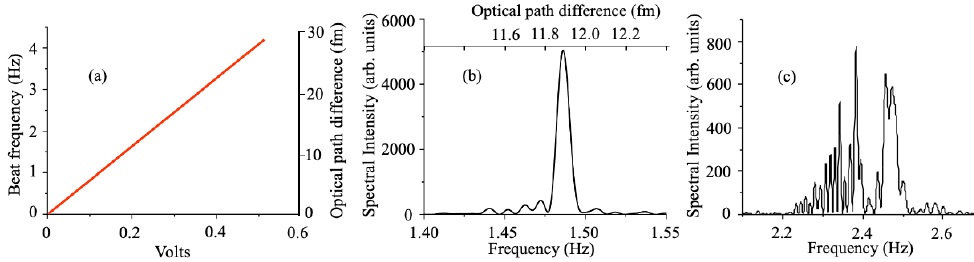
Figure 6. ( a ) Beat frequency versus voltage applied to the LiNbO 3 modulator; ( b ) absolute value squared of the Fourier transform of the beat signal for a time span of 100 s, with the OPO cavity stabilized with respect to the pump cavity. The upper abscissa indicates the optical path difference corresponding to the frequency scale; ( c ) absolute value squared of the Fourier transform of the beat signal for a time span of 100 s with the stabilization turned